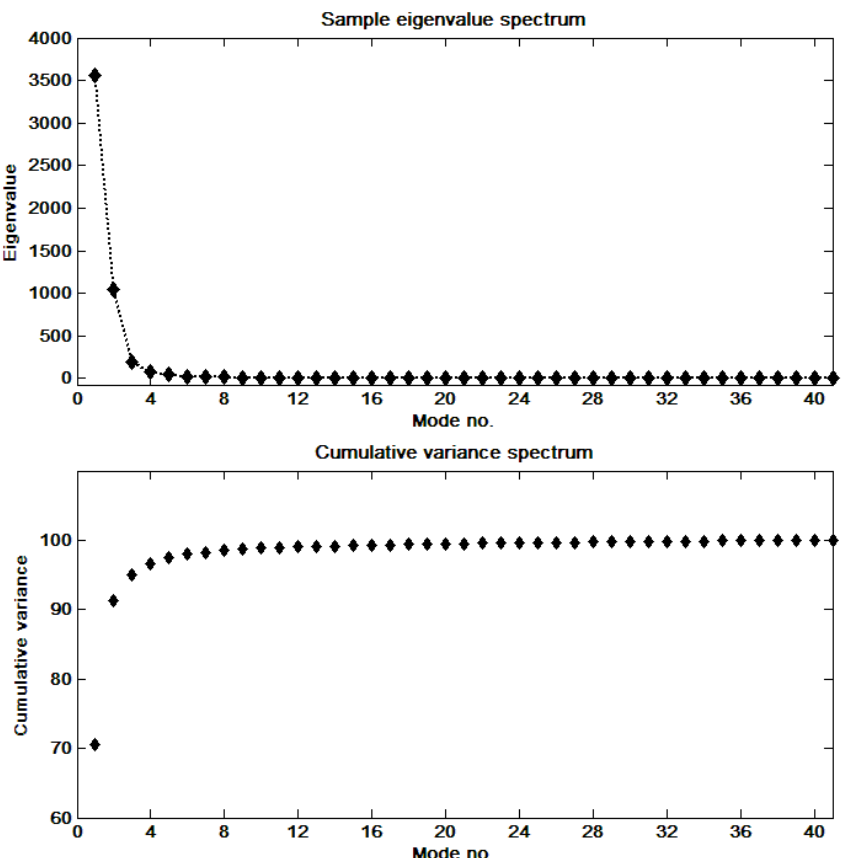
Figure 7. Fig. 7. Sample eigenvalue spectrum (upper panel), and cumulative variance spectrum (lower panel) from the cEOF analysis of current profiles for the period September–October 2002.